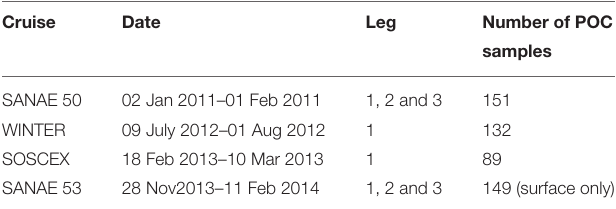
TABLE 1 | Names and dates of the various cruises indicating the different legs covered and the number of POC samples per cruise, with leg 1 between Cape Town and Antarctica along the GoodHope Line, leg 2 from Antarctica to South Georgia and leg 3 along marginal ice zone (Figure